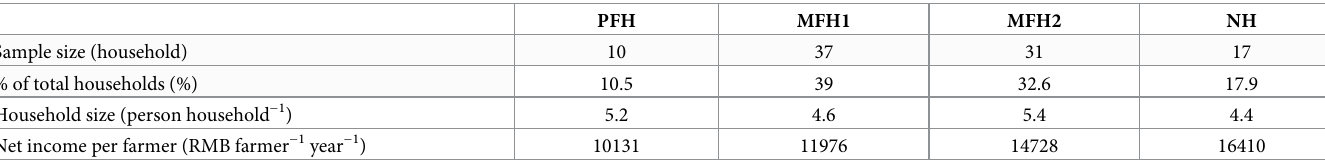
Table 1. The characteristics of sampling rural